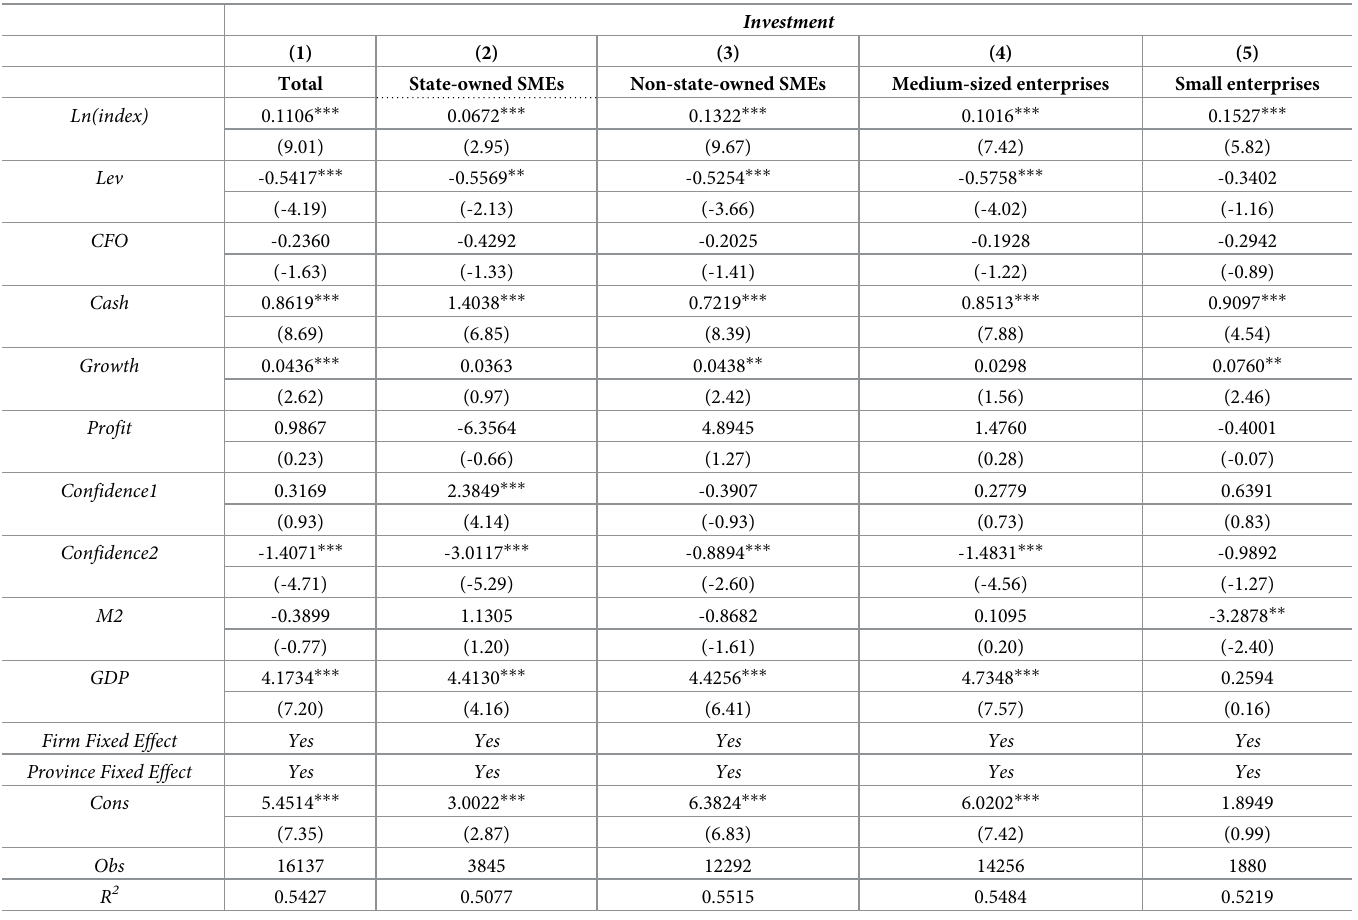
Table 6. Empirical results of the investment opportunity